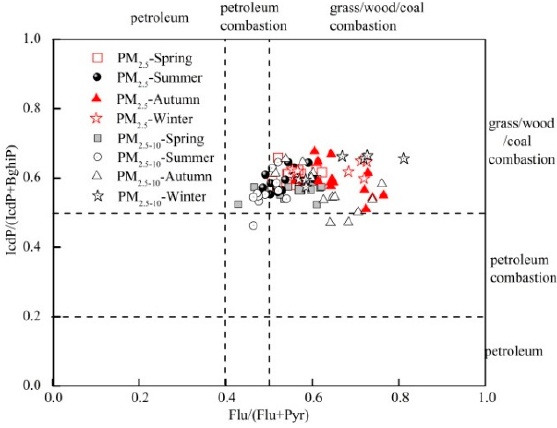
Figure 4. Ratios of IcdP/(BghiP + IcdP) vs. Flu/(Pyr + Flu) for PM 2.5 and PM 2.5–10 .